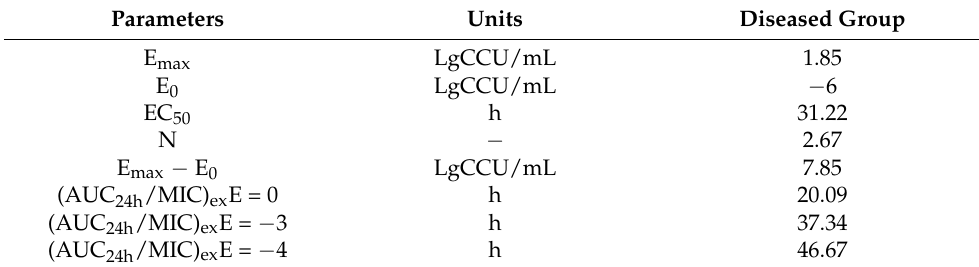
Table 3. The Sigmoid Emax model of danofloxacin in the lung.